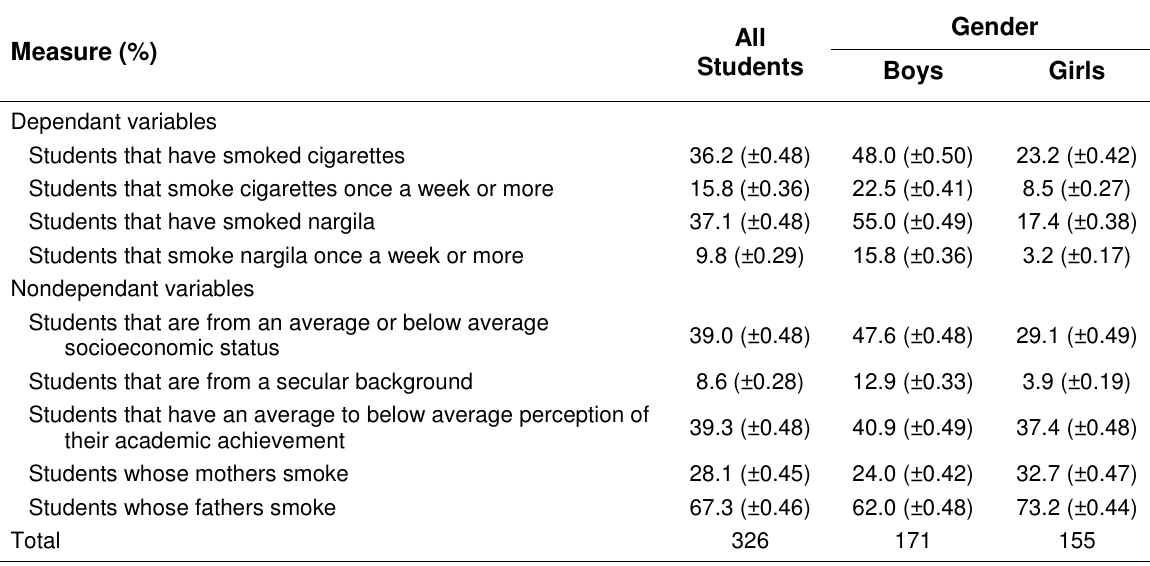
Distribution of Variables by